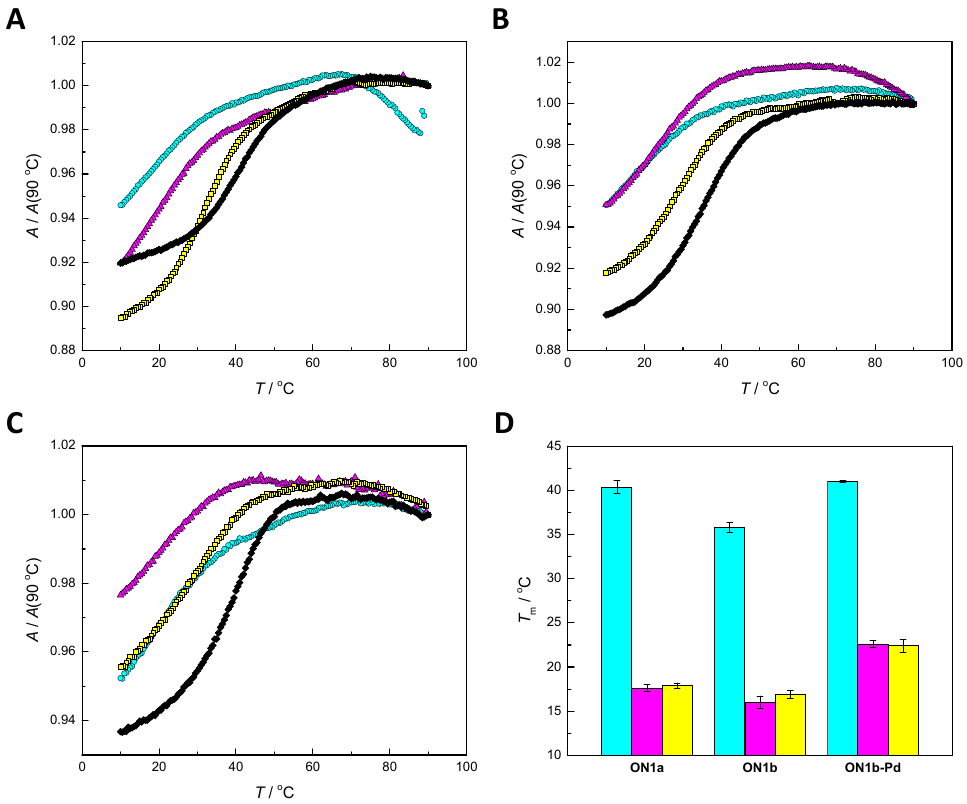
Figure 2. UV melting profiles for duplexes formed by ON5a with ( A ) ON1a (cyan circles), ON2a (magenta triangles), ON3a (yellow squares) and ON4a (black diamonds); ( B ) ON1b (cyan circles), ON2b (magenta triangles), ON3b (yellow squares) and ON4b (black diamonds) and ( C ) ON1b-Pd (cyan circles), ON2b-Pd (magenta triangles), ON3b-Pd (yellow squares) and ON4b-Pd (black diamonds); ( D ) melting temperatures of duplexes formed by ON1a , ON1b and ON1b-Pd with ON5a (cyan), ON5g (magenta) and ON5t (yellow); pH = 7.4 (20 mM cacodylate buffer); [oligonucleotides] = 3.0 µM; I (NaClO 4 ) = 0.10 M. The error bars represent standard deviations of three independent measurements.